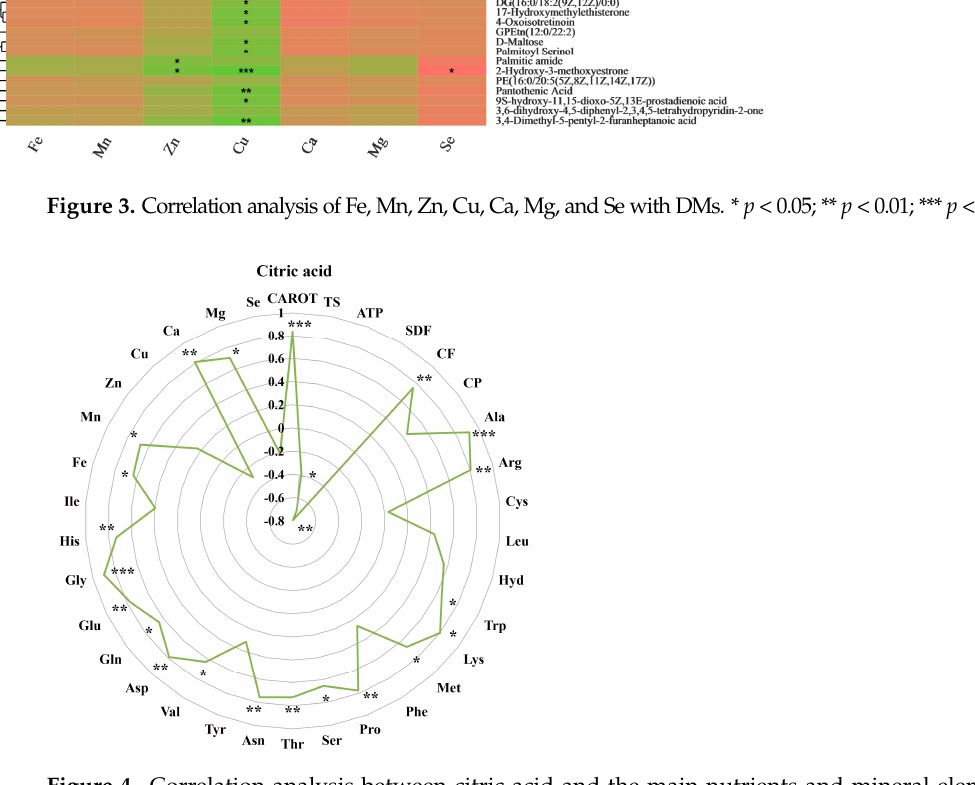
Figure 4. Correlation analysis between citric acid and the main nutrients and mineral elements. * p